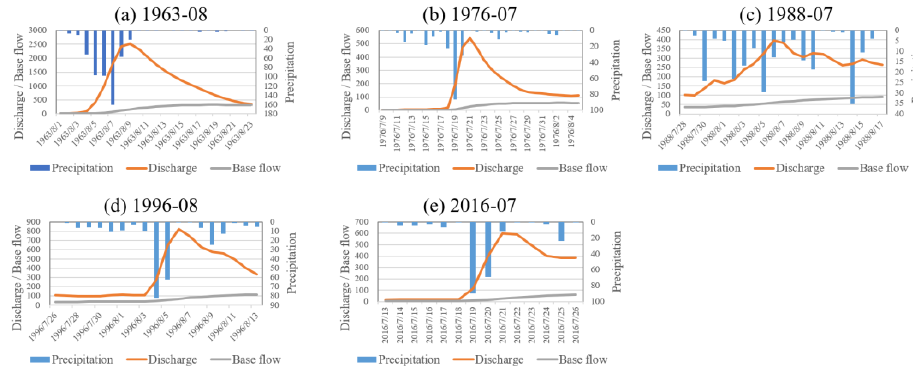
Figure 4. Relationships between daily rainfall and daily discharge during the main flood episodes in the Zhulong river watershed.